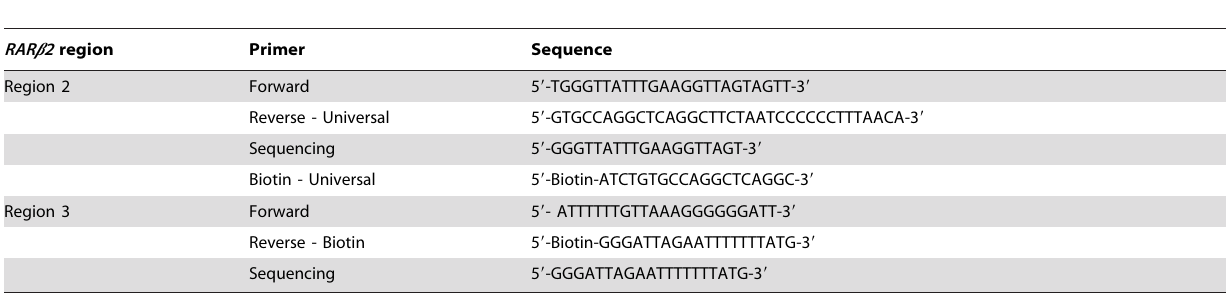
Table 3. A list of the PCR and sequencing primers used for the bisulfite pyrosequencing of the RAR b 2 regions 2 and 3.